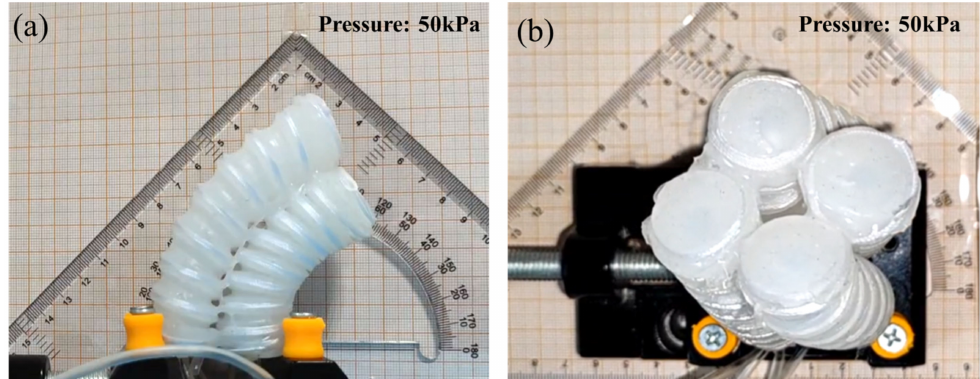
Figure 7. Soft wrist motion test: ( a ) bending; ( b ) twisting.